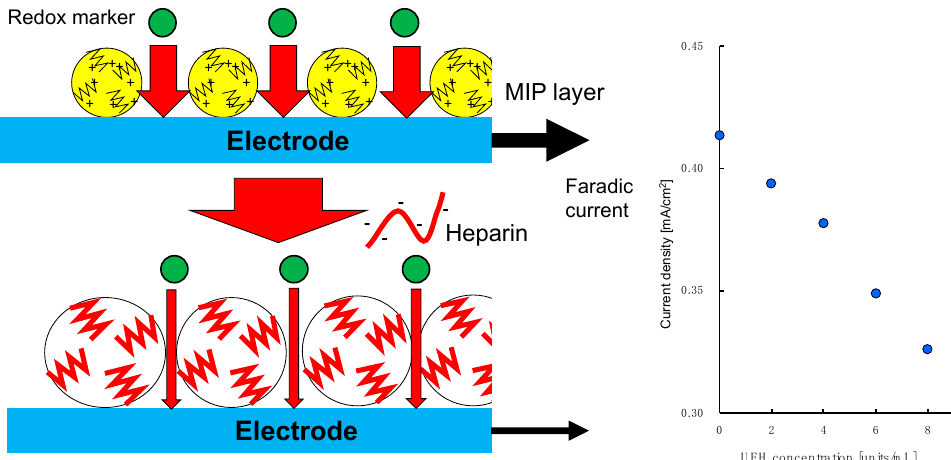
Figure 6. Scheme of the possible mechanism of heparin sensing with an indium–tin oxide electrode grafted with UHF-MIP where the faradic current decreased with increased UFH concentration as shown on the right-hand side [15].